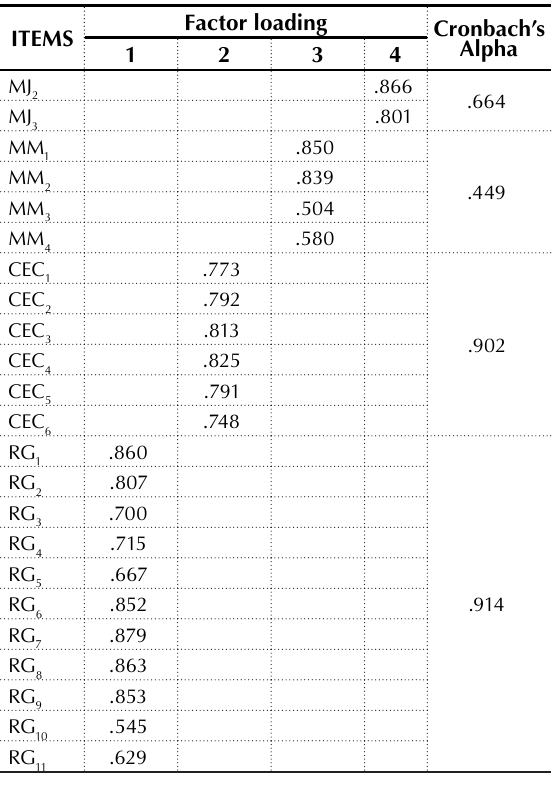
Table 3. Factor loading and Cronbach’s